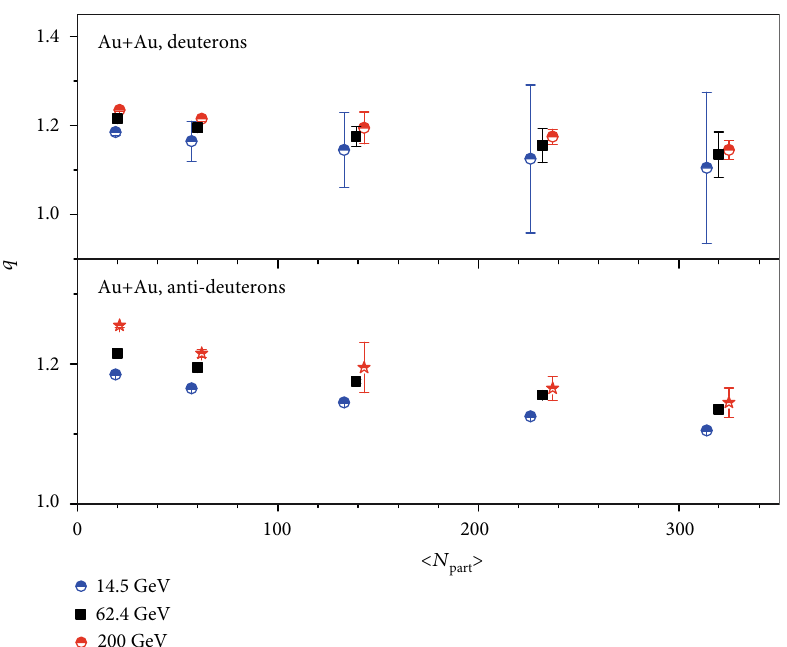
Figure 9: Dependence of q on the average number of participants for deuterons and antideuterons in events with di ff erent centrality intervals. The symbols represent the parameter values listed in Tables 2 –